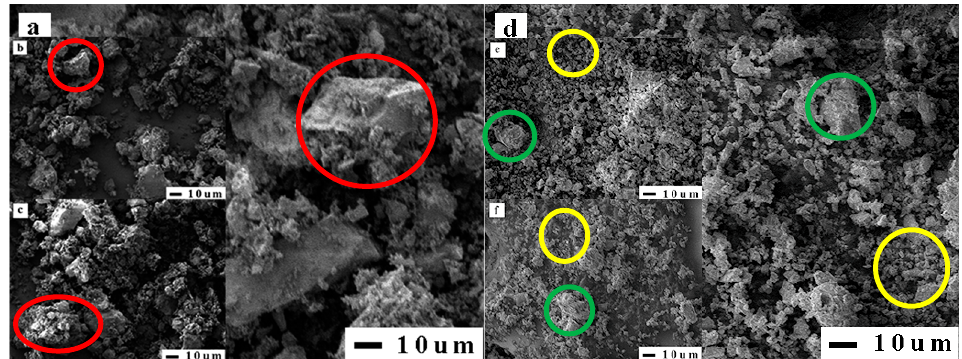
Figure 11. Surface area of various RPs. Materials 2019 , 12 , x FOR PEER REVIEW